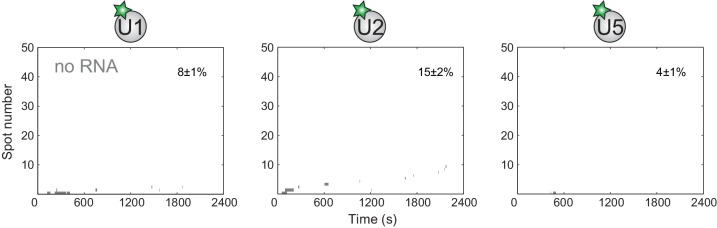
Complete microscope field of view (48 μm x 49 μm, grayscale) containing the region shown in Figure 2C (yellow box).RNA molecules were visualized under red laser excitation after both 5i3 and 3e5 molecules were tethered. The four brightest spots are fluorescent beads used as fiducial markers to correct for stage drift.